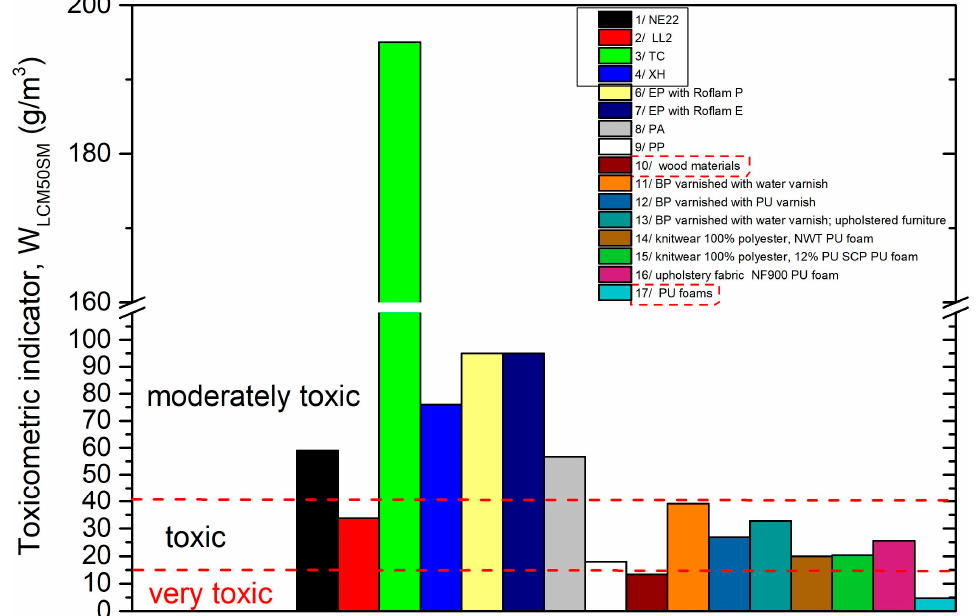
Figure 8. Comparison of the toxicometric indicator (W LC50SM ) with toxicity classification of